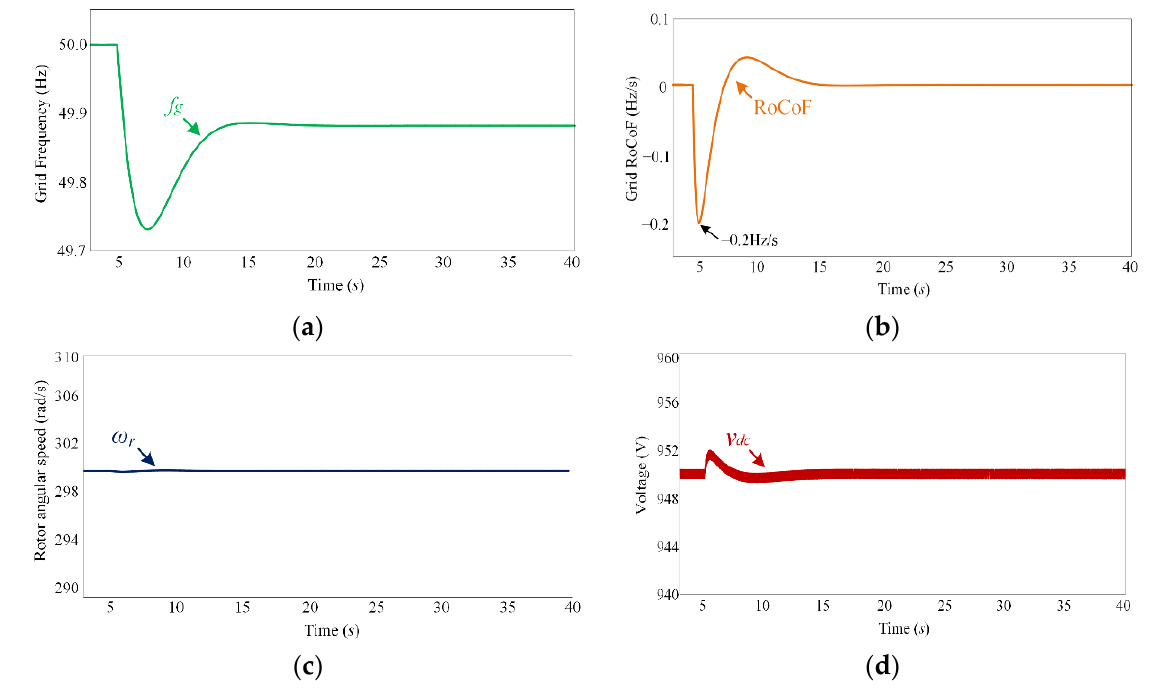
Figure 12. Simulation results when the DFIG system does not have an inertia-provision function. ( a ) Grid frequency; ( b ) grid RoCoF; ( c ) rotor angular speed; ( d ) DC-link voltage.